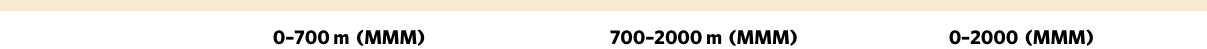
Table 1 Observed and simulated ocean heat content anomaly trend.